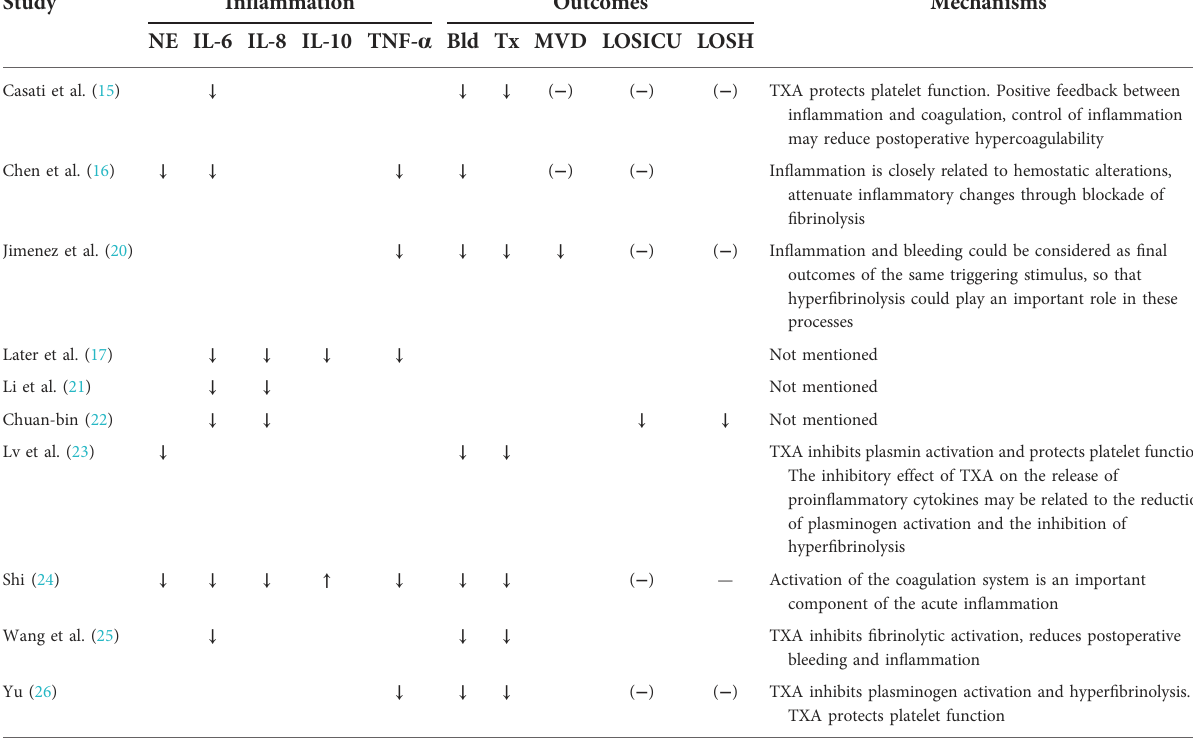
TABLE 6 In fl ammation and clinical outcomes of TXA administration. Study In fl ammation Outcomes